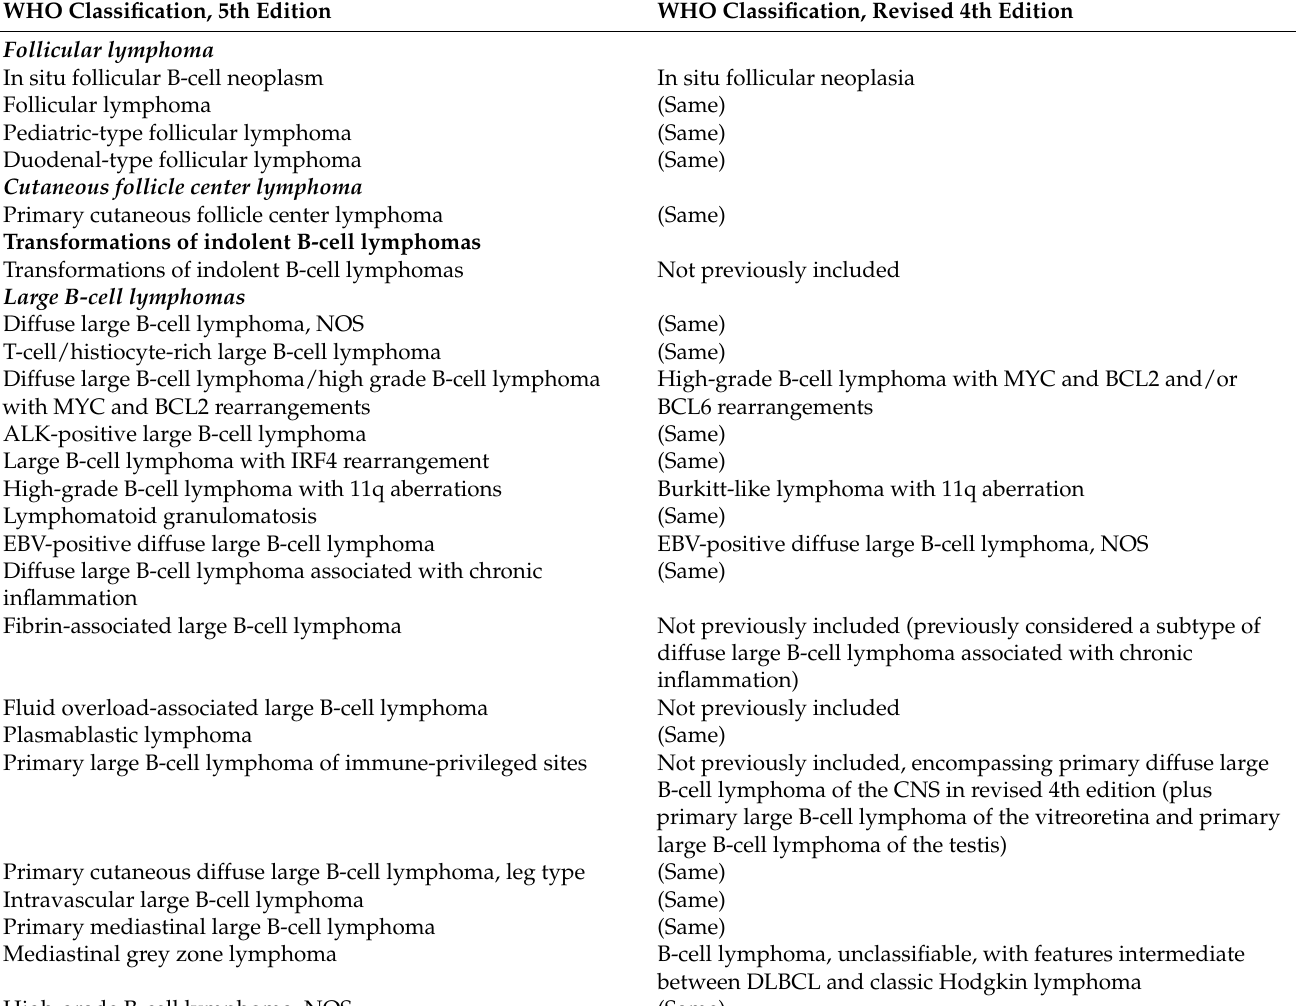
Table 1. WHO Classification of Haematolymphoid Tumours, 5th edition : B-cell lymphoid proliferations and lymphomas